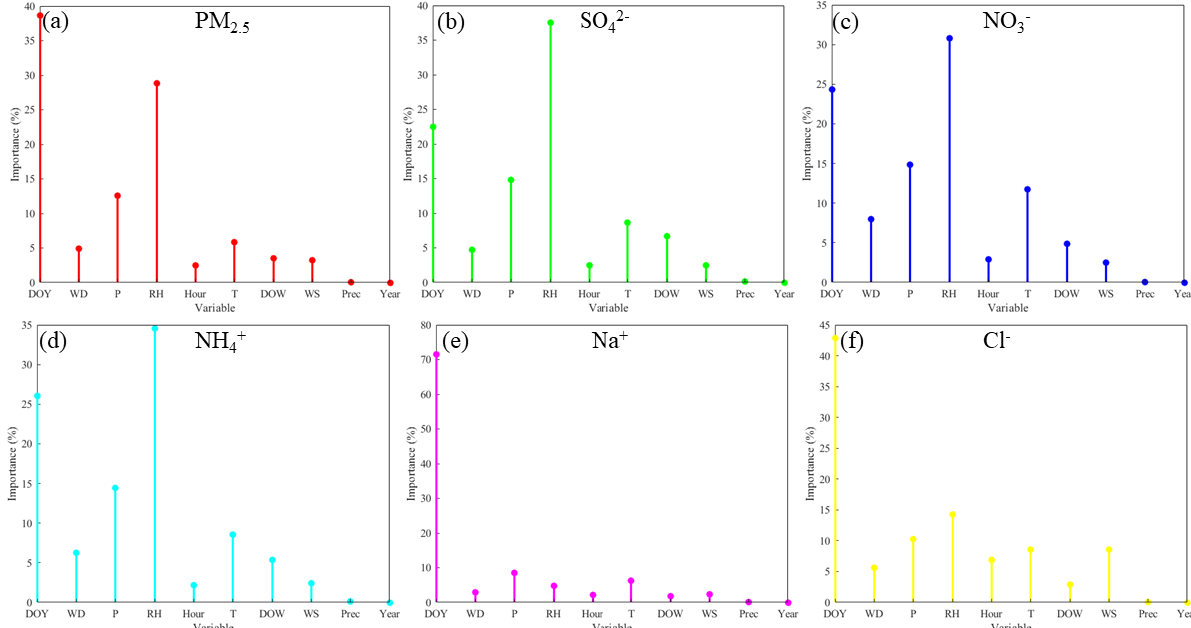
Figure 8. Relative importance of the predictors for the prediction of water-soluble ions in PM 2 . 5 . The match in the figure denotes the variable importance in RF models for various species. DOY, WD, P , RH, Hour, T , DOW, WS, Prec, and Year represent day of year, wind direction, air pressure, relative humidity, hour of the day, air temperature, day of week, wind speed, precipitation, and study year.